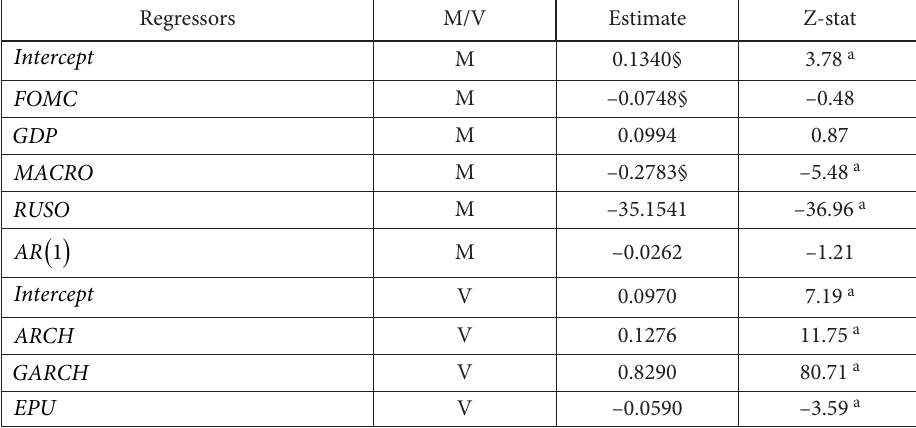
Table 10. Economic policy uncertainty and USO ETF oil volatility index